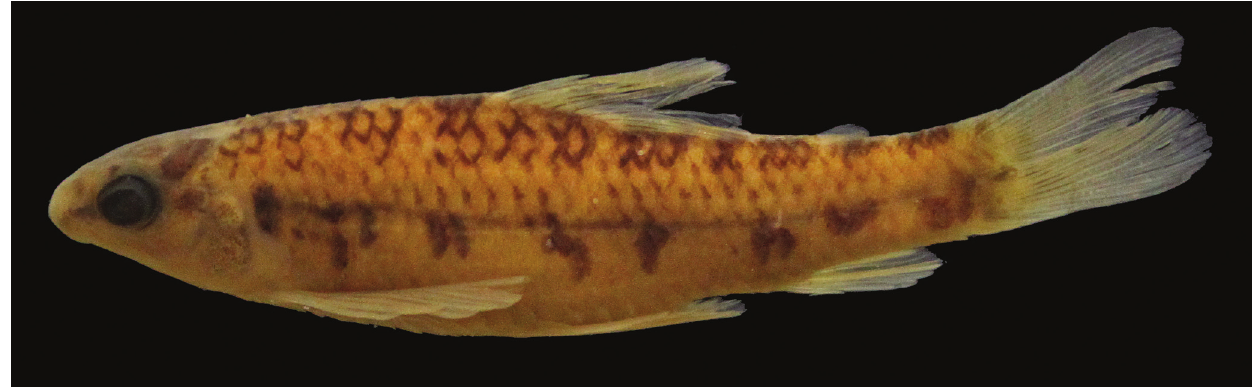
Fig. 6. Lateral view of Characidium heirmostigmata , NUP 1393, paratype, 39.8 mm SL, showing color pattern and general shape of the